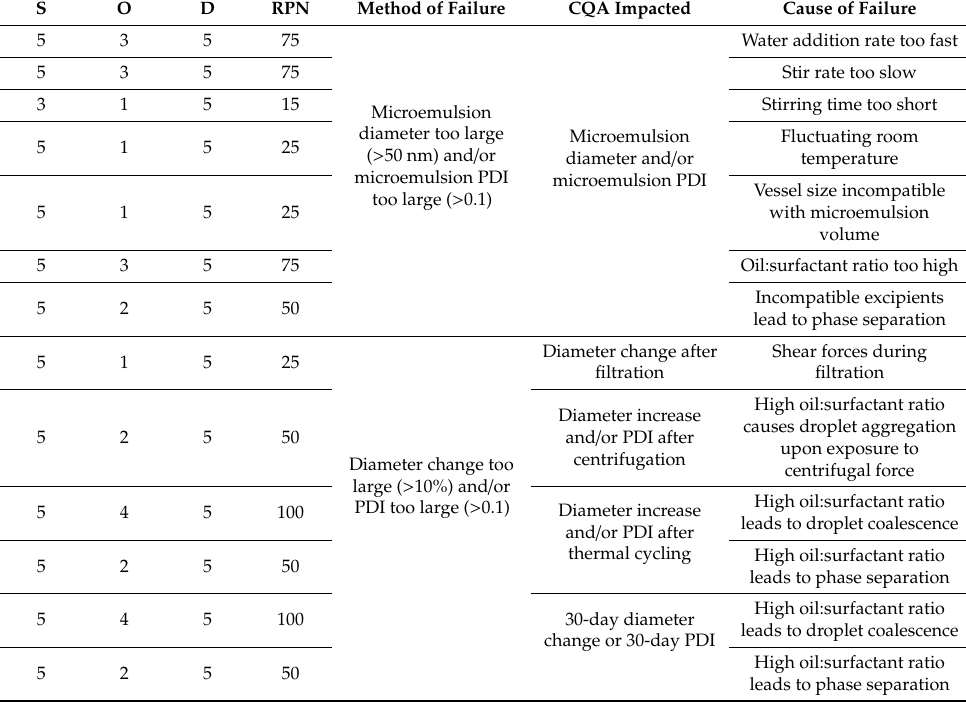
Table 3. Abridged risk analysis with rankings. Using ranked risk priority numbers (RPNs), a methodical risk assessment identified the most influential parameters on microemulsion critical quality attributes. These parameters were studied in a screening mixture process variable design of